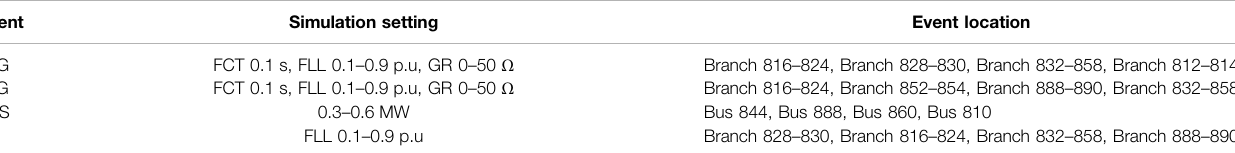
TABLE 2 | Different events simulated in the IEEE 34-bus system.